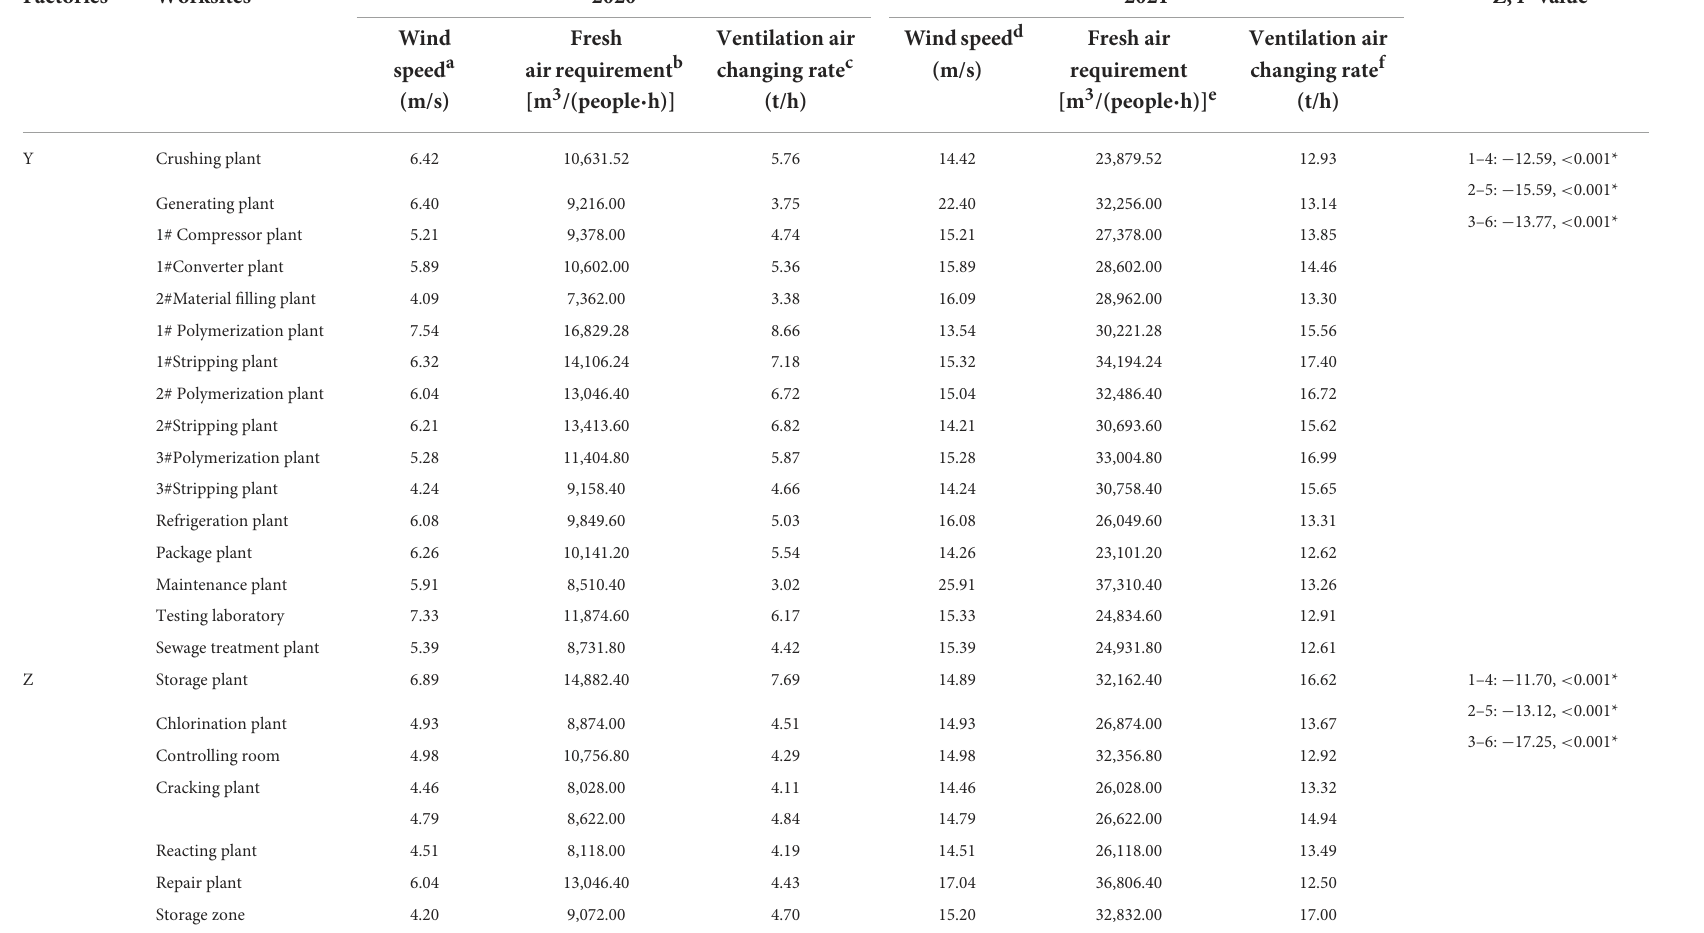
TABLE 4 Comparison results of wind speed, fresh air requirement and ventilation air changing